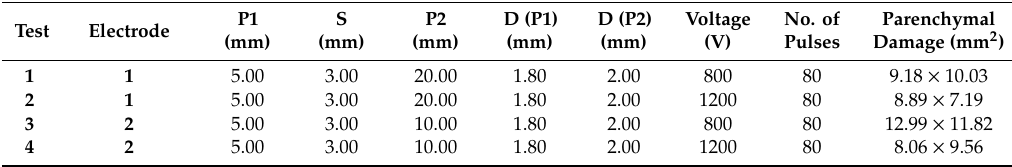
Table 3. Electrodes for in vivo experiments. Details of the damaged parenchyma using the setting of